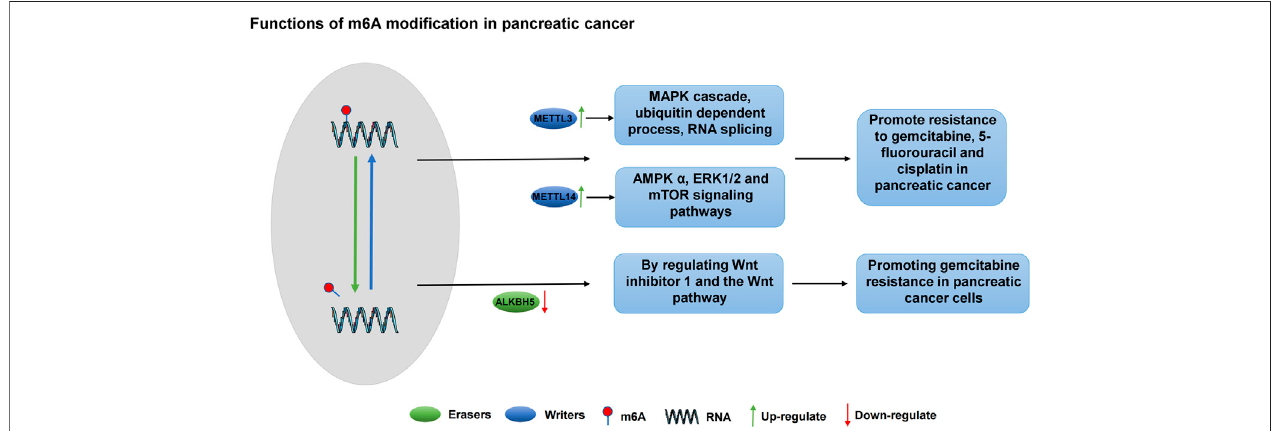
FIGURE 3 | The regulatory mechanism of m6A modi fi cation on chemotherapy resistance in pancreatic cancer. METTL3 and METTL14 are up-regulated in pancreaticcancerandpromotedrugresistance togemcitabine,5- fl uorouraciland cisplatinthroughMAPKcascade, ubiquitin-dependent process,RNAsplicing,AMPK α , ERK1/2, and mTOR signaling pathways. The down-regulated expression of ALKBH5 in pancreatic cancer affects the sensitivity of pancreatic cancer cells to gemcitabine by regulating Wnt inhibitor 1 and the Wnt pathway.